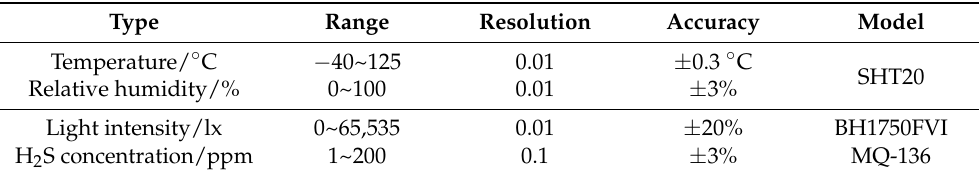
Figure 4. The structure diagram of the environmental information sensing unit structure. Table 3. The environmental sensors performance